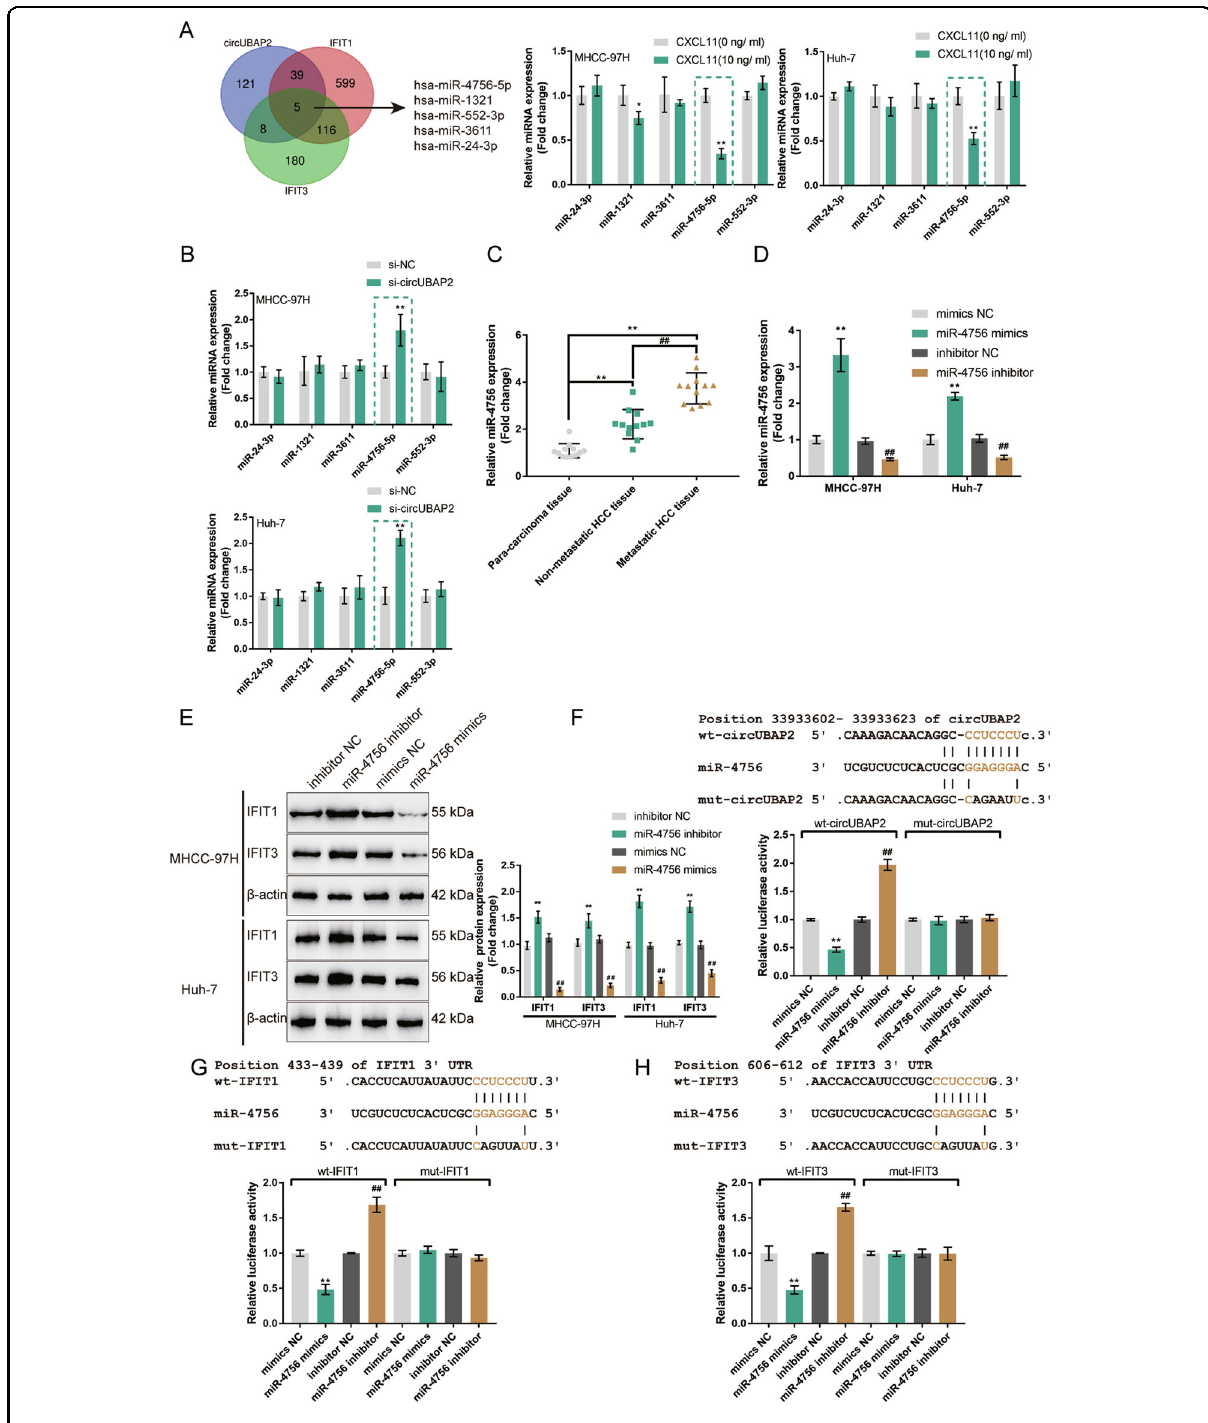
Fig. 6 (See legend on next